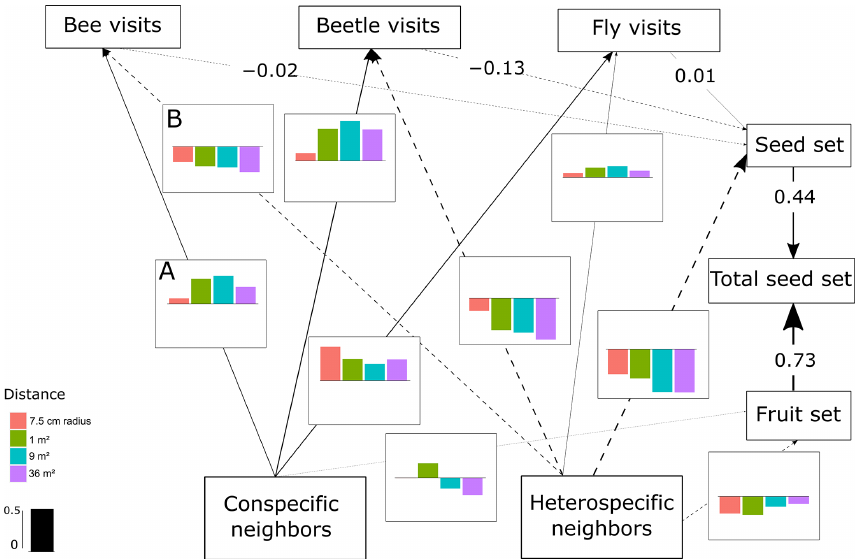
Figure 2. SEM of C. fuscatum , which includes the differences in the interactions between scales. The lines (dashed and solid lines) are proportional to the magnitude of the relationship (when different scales are relevant, we plot the mean of the standardized total effects across scales). The dashed lines are the negative relationships. When numbers are included on the paths instead of in the plot with the effect size bars across scales, it describes the standardized total effect, which remains the same across scales. The bar plots show the standardized total effects of each relationship across the different scales, and the bar in the legend represents the value of 0.5 as a visual aid. If the value of the bar plot is positive, it means that it has a positive effect, and if it is negative, it means that it has a negative effect. It is important to mention that the correlations between the variables are not visualized on the path, but in the SEM they are included (Eq. A1, Appendix A) ( p value = 0.813; df = 48; R 2 of individual total seed set =∼ 0.80). In this figure we include an example of how to read the figure. For example, line A indicates that the density of conspecific neighbors affects bee visits positively at all scales, while line B indicates that the density of heterospecific neighbors negatively affects bee visits at all